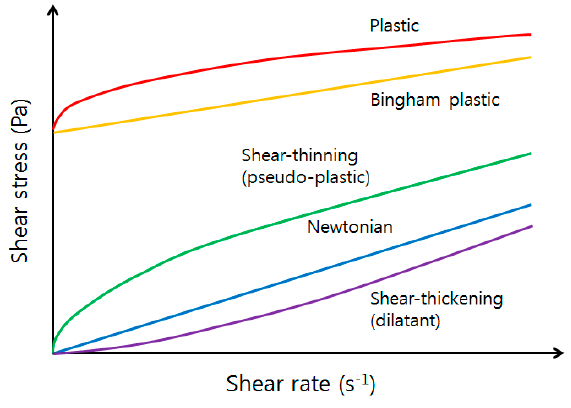
Figure 1. Schematic flow curves of Newtonian and non-Newtonian materials.